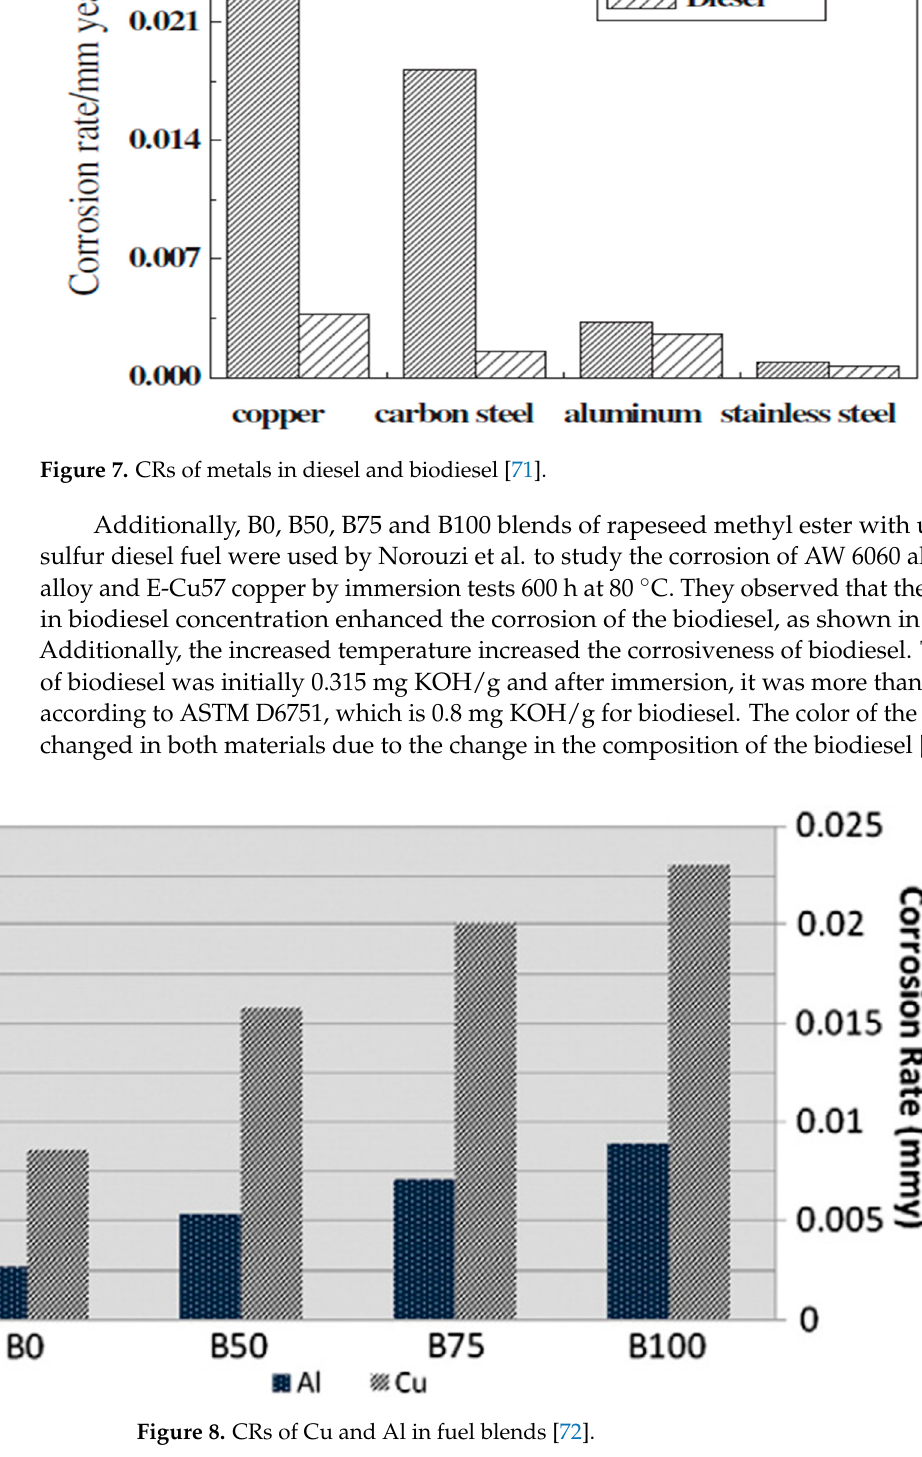
Figure 8. CRs of Cu and Al in fuel blends [72].